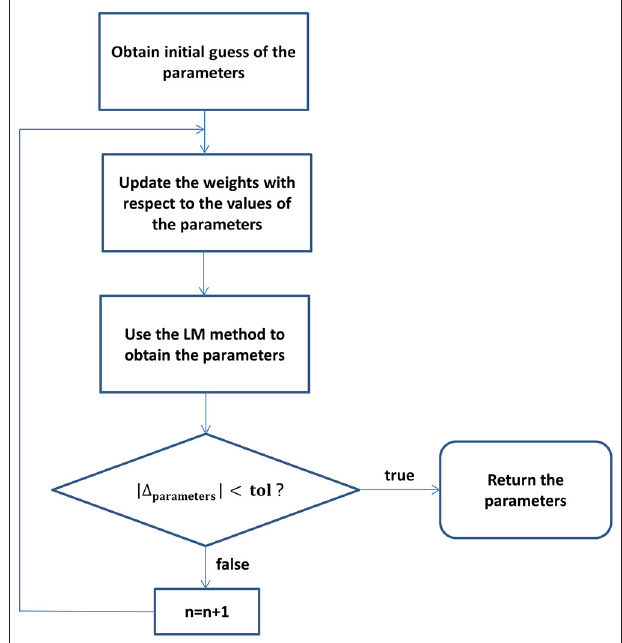
FIGURE 2 | The flow chart describing the steps of the Levenberg–Marquardt (LM) optimization method.